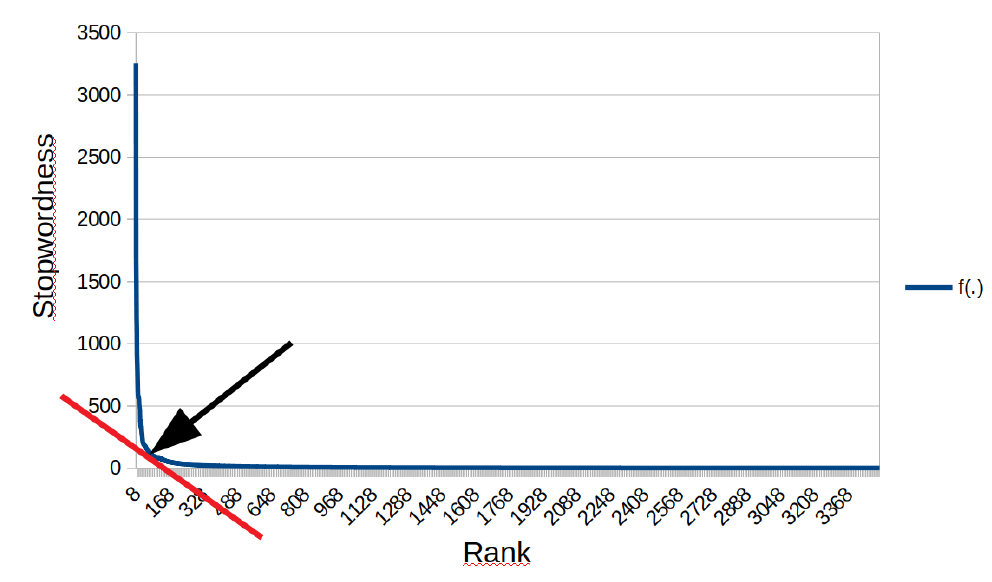
Figure 1. Geometric cutpoint assessment. Algorithm 2 Cutpoint